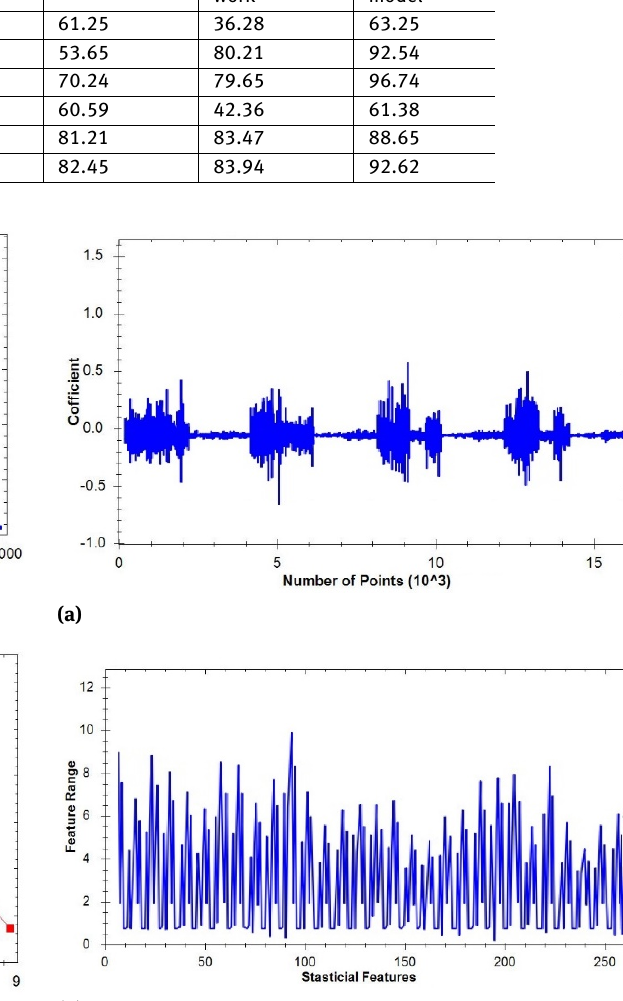
Figure 7: Feature analysis in time-frequency domain for fault diag- nosis: (a) Waveform in time-frequency domain of the first signal;